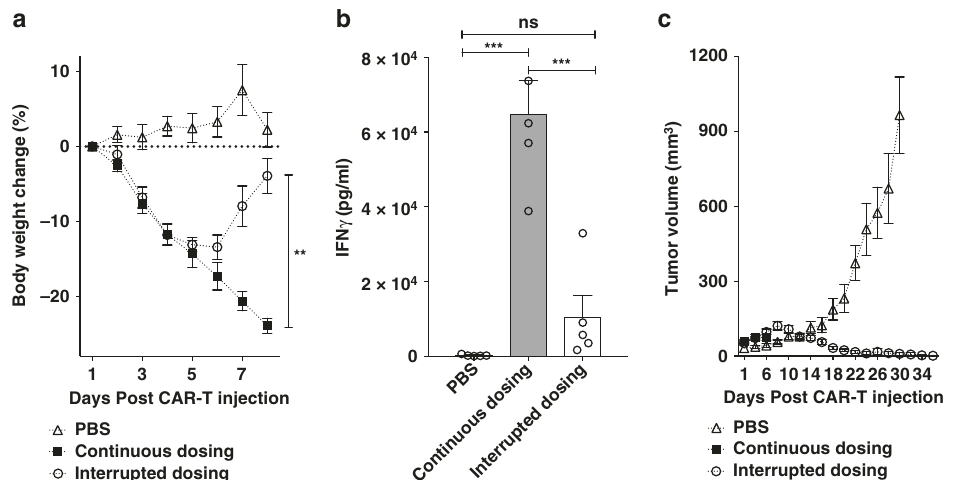
Fig. 4 Control of CRS intensity by interruption of bispeci fi c adapter administration. a Analysis of bodyweight change (%) as a measure of CRS intensity after administration of a high dose of anti- fl uorescein CAR T cells (15 × 10 6 ) in either absence (PBS) or presence of FITC-folate (500 nmole/kg administered on days 1, and 2, and alternate days thereafter). In the interrupted dosing regimen, the continuous dosing schedule was followed except FITC- folate injections were omitted on days 4 and 6. b Analysis of IFN γ levels in mouse plasma on day 6 using the dosing regimens described in a . c Measurement of tumor volumes in mice treated as described in a . n = 5 mice per group. Data represent mean ± s.e.m. One-way ANOVA with post-hoc Tukey tests were performed for all comparisons (*denotes a p- value < 0.05, ** < 0.01, *** < 0.001, ns = not signi fi